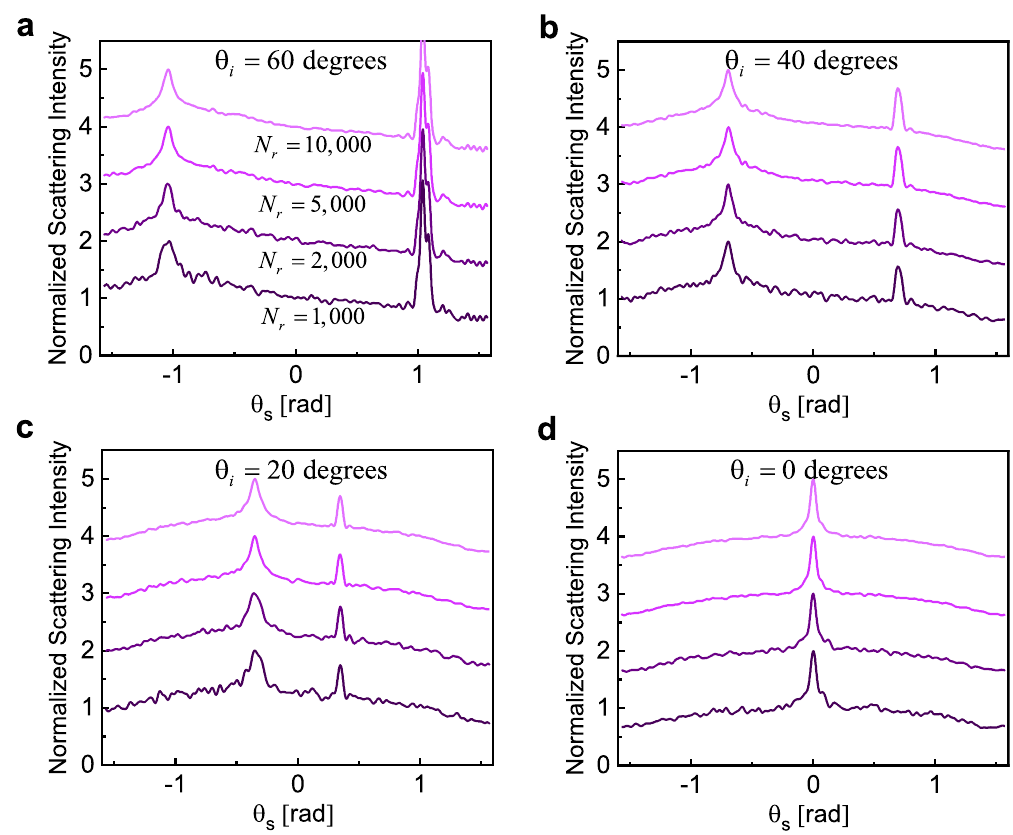
Figure 3. Normalized ensemble-averaged scattering intensity for random samples with N p = 10, 000 , L = 20 (cid:31) 0 , and ρ = 0.021 . Results are averaged over N r = ( 1, 000 ; 2, 000 ; 5, 000 ; 10, 000 ) different simulations, with darker colors corresponding to smaller N r in each case. The maximum averaged intensity in each curve is normalized to two, and for better visualization each curve is moved one unit up compared to the previous one. The angle of incidence is set at ( a ) θ i = 60 (deg) , ( b ) θ i = 40 (deg) , ( c ) θ i = 20 (deg) , and ( d ) θ i = 0 (deg) .